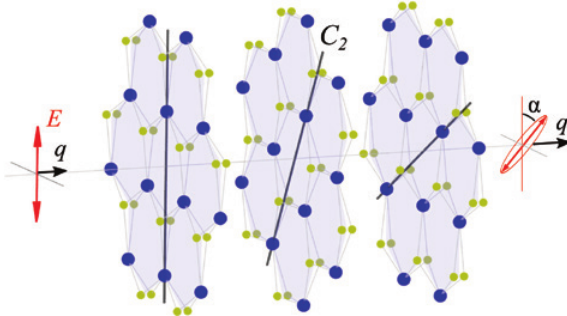
Figure 1: A sketch of a chiral stack of TMDC layers. Linearly polarized light passing through the chiral stack rotates its polarization plane and acquires